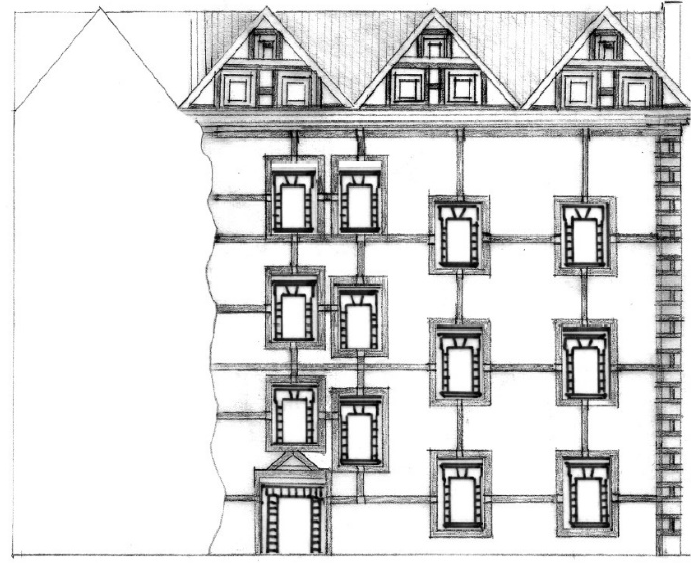
Figure 22. The remains of the sgraffito decoration and the preserved iconographic materials allowed reconstruction of the decorations in a frame arrangement on the facades of the manor house in Stara Kraśnica. Author’s study.